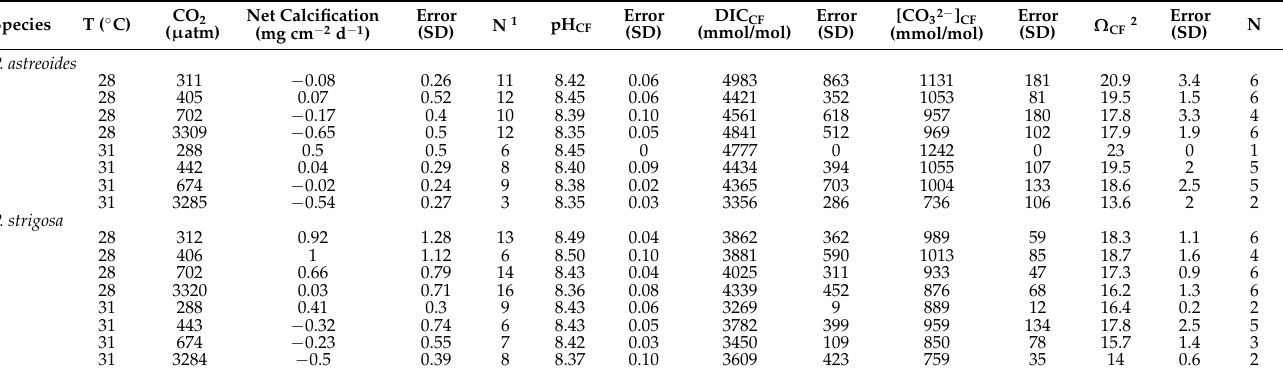
Figure 4. ( A ) Measured net calcification rate (mg cm − 2 d − 1 ) replotted from Bove et al. [38] ( B ) B/Ca-derived carbonate ion concentration of the coral calcifying fluid ([CO 32 − ] CF , µ mol/mol), and ( C ) combined δ 11 B and B/Ca-derived dissolved inorganic carbon concentration of the coral calcifying fluid (DIC CF , µ mol/mol). Triangle symbols ( ± 1 SD) represent the mean value for each treatment condition, blue and red symbols represent the 28 ◦ C and 31 ◦ C treatment conditions, respectively. Linear versus centered quadratic fit was determined using the Akaike Information Criteria test (Table S8), with shading representing the 95% confidence interval. * indicates a significant difference between 28 ◦ C and 31 ◦ C data for a given p CO 2 treatment, as demonstrated by a p -value < 0.05 in a Welch’s-T test. Table 3. Net calcification data and calculated calcifying fluid pH and carbonate system